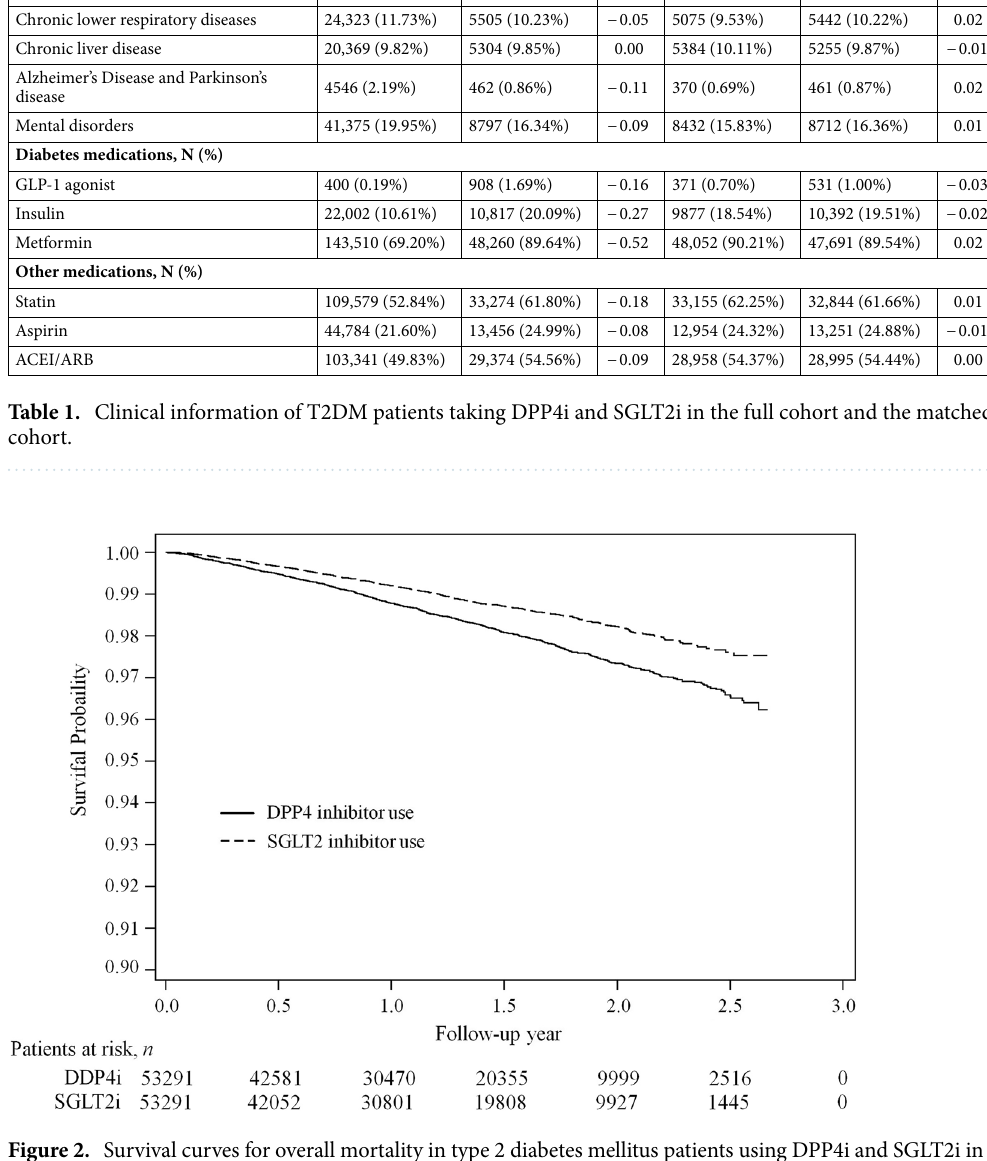
Figure 2. Survival curves for overall mortality in type 2 diabetes mellitus patients using DPP4i and SGLT2i in the propensity score matched